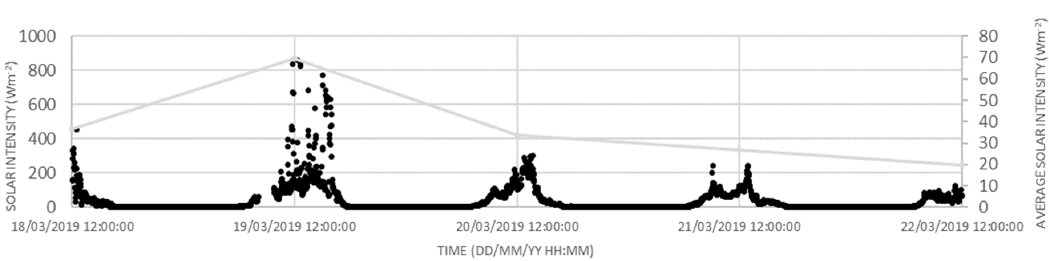
Figure 17. The measured solar intensity in the third week.